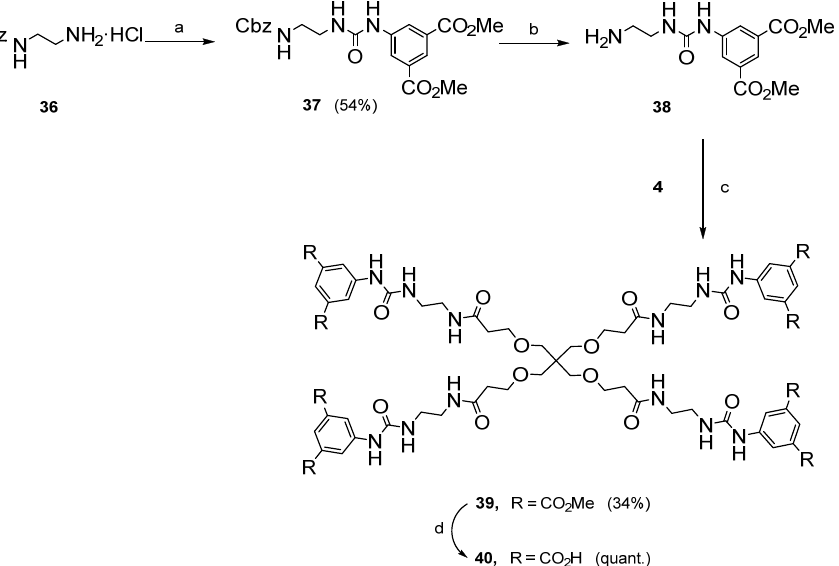
Table 1. Anti-HIV-1/HIV-2 activities of the synthesized